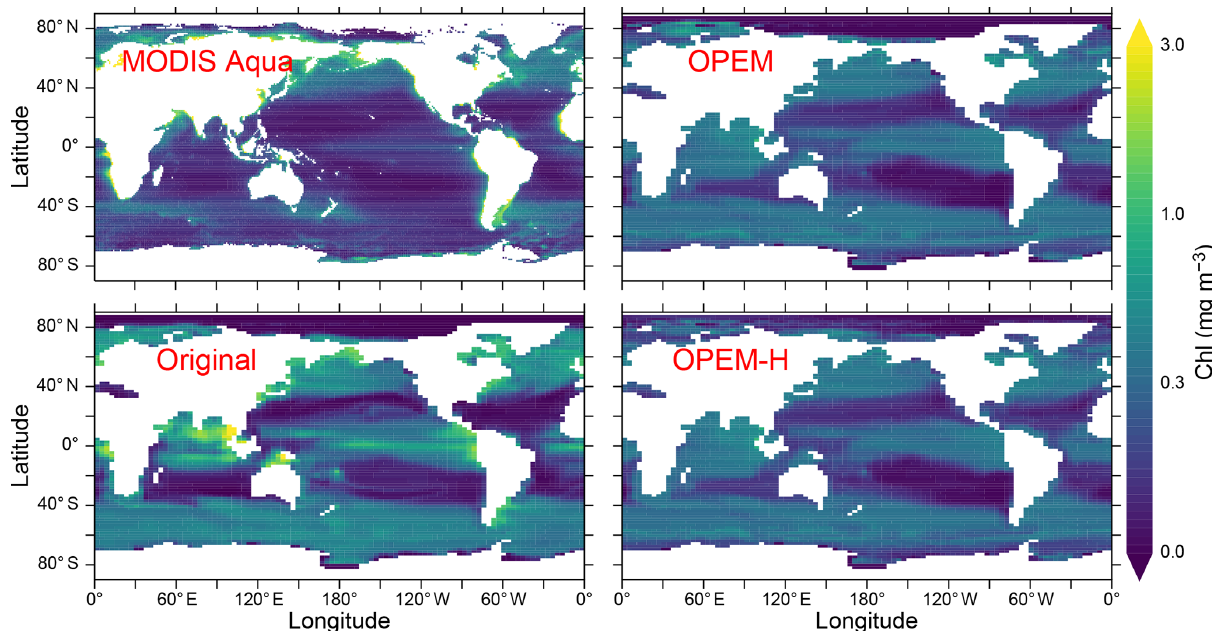
Figure 9. Annually averaged distribution of surface Chl estimated from MODIS Aqua (level 3) data for 2002–2019 and predicted from the original, OPEM, and OPEM-H UVic simulations. The MODIS Aqua averages in the top-left panel treat missing data as 0. Chl is calculated assuming Chl : N = 1 . 59gmol − 1 (Oschlies et al., 2000) for the original UVic model. Note that the surface layer is 50m thick in UVic, whereas the satellite estimate is for the upper ∼ 20m.